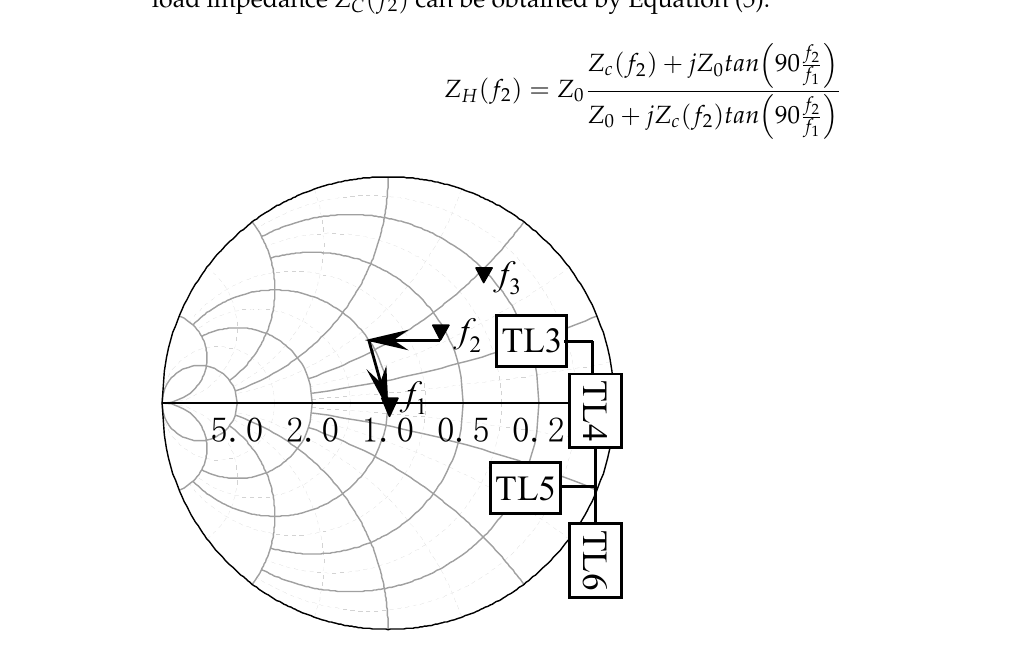
Figure 3. The matching circuit for the second frequency band.